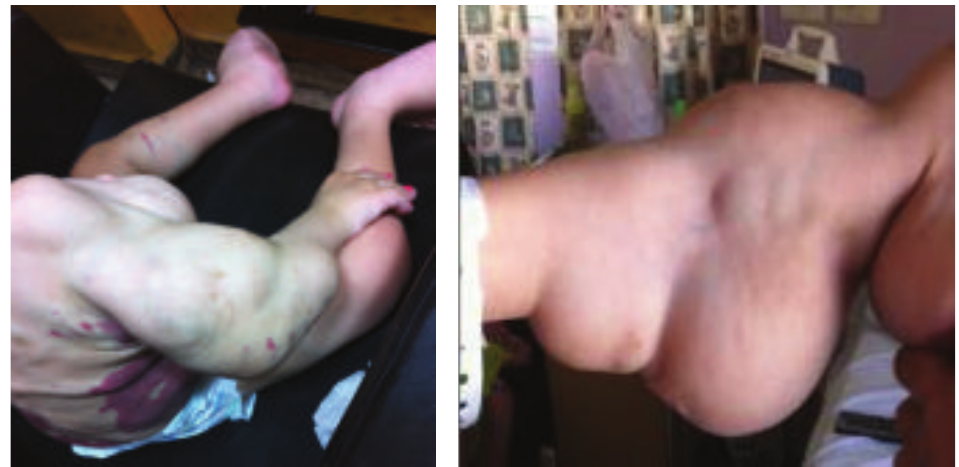
Figure 2: Multiple focal overgrowth of the right